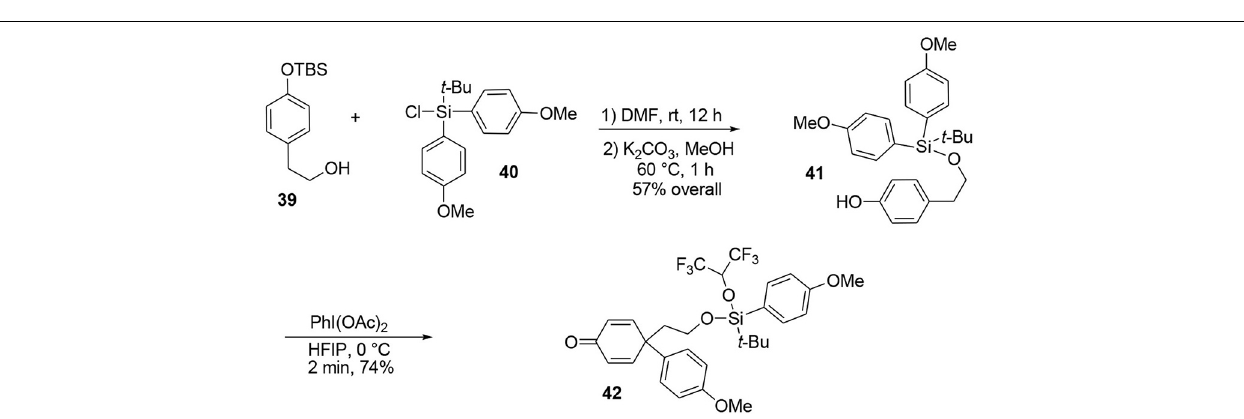
Scheme 11 | Quaternary carbon center formation by oxidative ipso